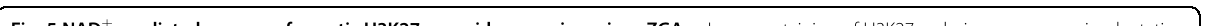
Fig. 5 NAD + -mediated erasure of zygotic H3K27ac avoids excessive minor ZGA. a Immunostaining of H3K27ac during mouse pre-implantation embryo development. One representative image from three independent experiments is shown. Scale bar, 25 μ m. b Quanti fi cation of H3K27ac fl uorescence intensity in mouse embryos. Each dot represents a single nucleus. c Alluvial plots showing the global dynamics of zyH3K27ac during early embryo development. d Representative confocal images of control, FK866-treated, and FK866 + NMN-treated late 2-cell embryos stained with H3K27ac antibody. Scale bars, 25 µm. e Quanti fi cation of H3K27ac fl uorescence intensity in late 2-cell embryos. Each dot represents a single nucleus. f Heatmap showing H3K27ac signals ranked by their relative changes after FK866 treatment. NMN rescued the changes induced by FK866 treatment in late 2-cell embryos. g Metaplot of H3K27ac peaks ( Z -score normalized; n = 15,920) in control, FK866-treated, and FK866 + NMN-treated late 2-cell embryos. h Comparison of the distance between H3K27ac peaks and ZGA or coding genes in the genome. The Y -axis shows the proportion of H3K27ac peaks associated with genes. About 30% – 50% of H3K27ac peaks are distributed from the peak to a distance of 50 kb to the TSSs of minor ZGA genes, and the proportions are higher than those of major ZGA genes and other coding genes. i Pie charts showing the percentages of minor ZGA genes whose promoters enriched the zyH3K27ac at the zygote stage. ( j , l ) Metaplot showing the H3K27ac enrichment ( Z -score normalized) at the promoters of the minor ZGA genes ( j ) and major ZGA genes ( l ) at individual stages. ( k , m ) Metaplot showing the ATAC-seq enrichment ( Z -score normalized) at the promoters of the minor ZGA genes ( k ) and major ZGA genes ( m ) at individual stages. n Metaplot showing the Pol II enrichment ( Z -score normalized) at the promoters of minor and major ZGA genes at the early 2-cell stages. o Heatmap (left) showing H3K27ac signals ranked by their relative changes following FK866 or FK866 + NMN treatment. Heatmap (right) shows that minor ZGA genes were upregulated between control and FK866-treated embryos, and rescued by NMN supplementation. Mean values of two biological replicates were scaled and are represented as Z scores. p Genome browser view of RNA-seq and H3K27ac signals at the Dux locus in control, FK866-treated, and FK866 + NMN-treated late 2-cell